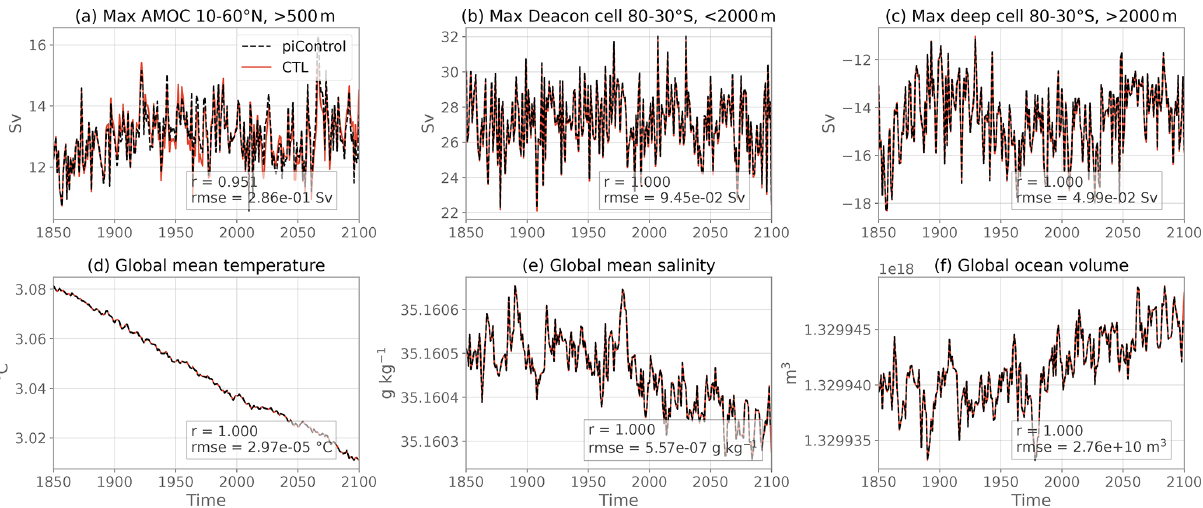
Figure 5. Annually averaged global and overturning diagnostic time series for the coupled piControl (black) and the flux-forced ocean-only CTL (red). The values in the bottom right corner correspond to the Pearson correlation coefficient ( r ) and to the root mean square error (RMSE) between the two time